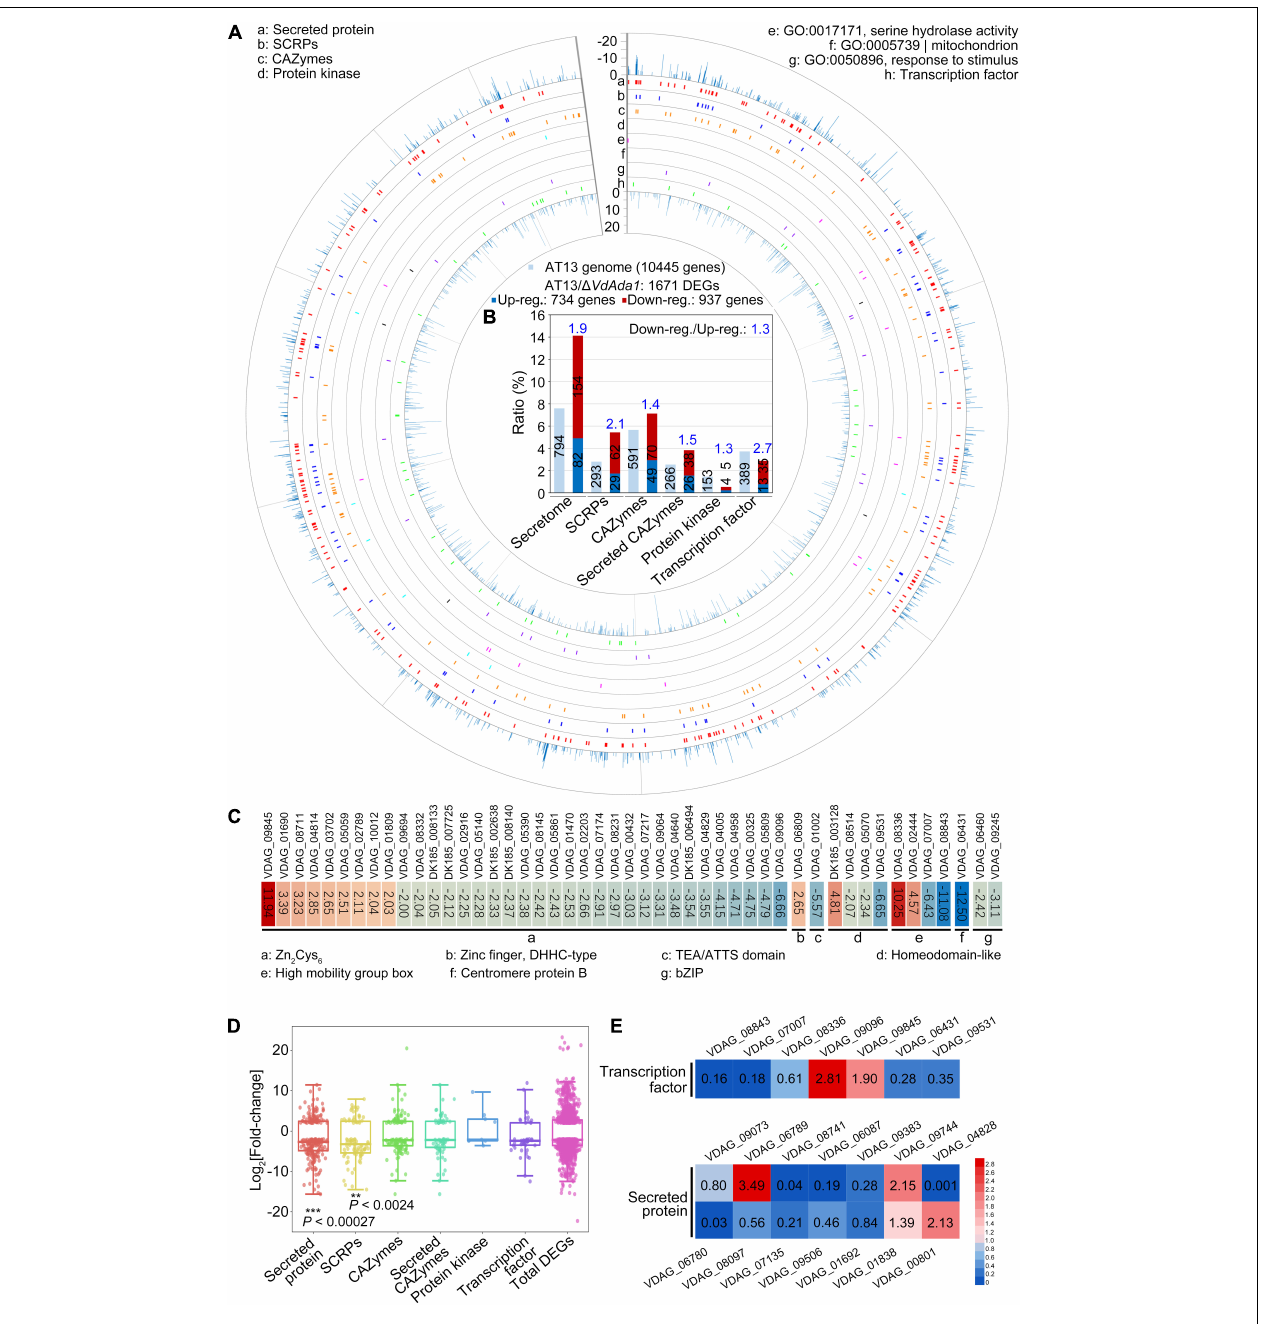
FIGURE 6 | RNA-seq analysis reveals altered transcription in the (cid:49) VdAda1 strain of Verticillium dahliae . (A) Expression pattern of 1671 DEGs in the (cid:49) VdAda1 genome compared to the wild type strain. The DEGs of (cid:49) VdAda1 versus wild type with cutoff log 2 ratio ≥ 2 and P -value < 0.01. (B) Bioinformatics analysis of potential virulence-related genes regulated by VdAda1 . The numbers in the columns indicate the number of different types of genes in the AT13 genome or DEGs. The numbers in blue above the columns indicate the ratio between downregulated and upregulated genes. (C) Heat map of differentially expressed transcription factors. Colored blocks from blue to red represent downregulated to upregulated genes, respectively; the fold change is the value of the log 2 ratio; the corresponding gene ID is at the top of the colored blocks, and the sequences of genes beginning with DK185 that was only found in strain AT13 but not in VdLs.17 reference genome were listed in Supplementary Table 3 . (D) Fold-change range of DEGs regulated by VdAda1 . The range of fold-change is displayed in the Box whisker plot. The central point in each box plot represents the median, the rectangle gives the interval between the 25 and 75% percentiles, and the whisker indicates the range. Significance of log 2 fold-change of secreted proteins and SCRPs compared with the total DEGs was identified using Student’s t -test. (E) Expression level of selected genes encoding secreted proteins and transcription factors were detected in the (cid:49) VdAda1 strain compared with the expression level in wild type strain by RT-qPCR. The expression level of each gene in wild type strain was set to 1. The numbers inside the colored blocks represent the fold change of each gene.